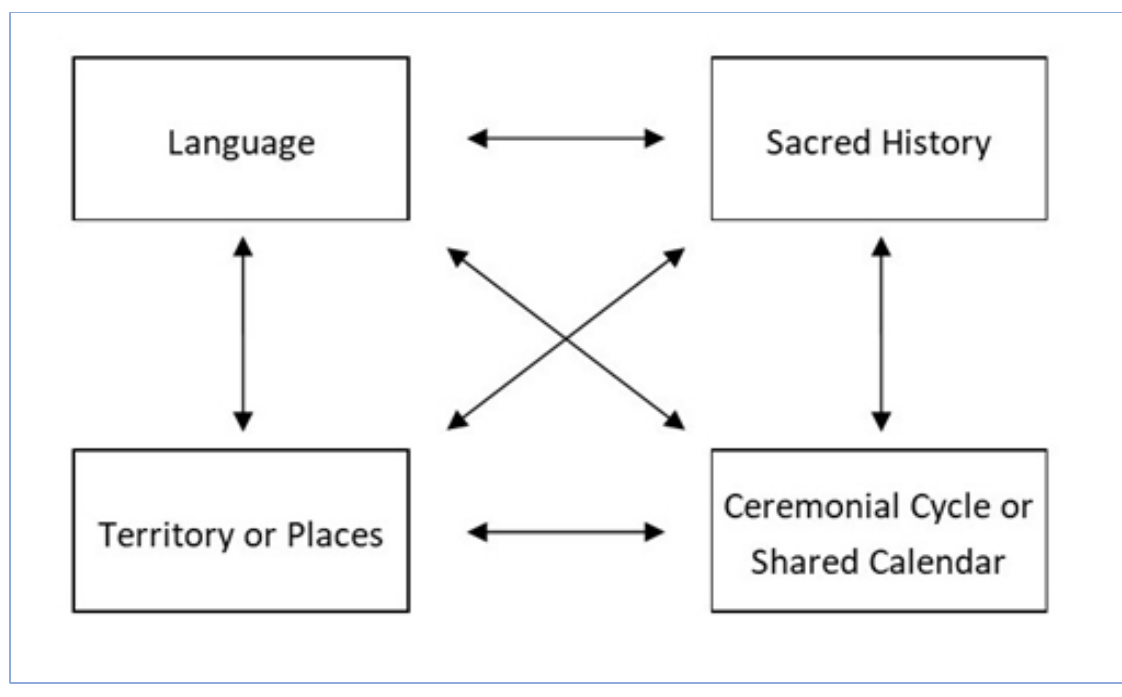
Adapted from Holm et al.